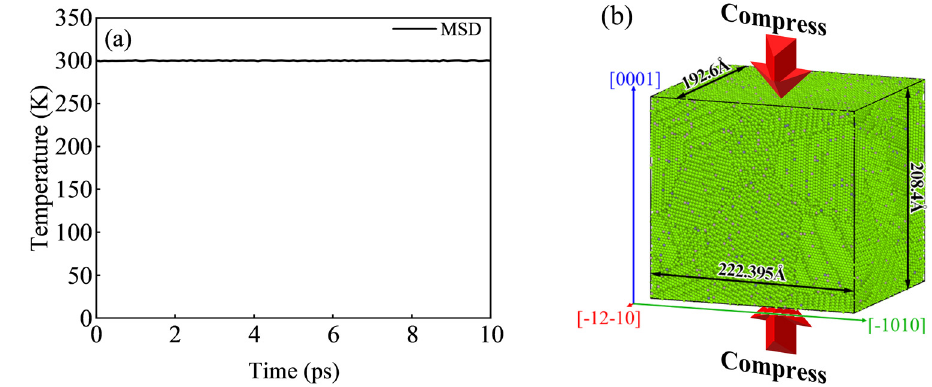
developed by Jang is assigned to the model. X , Y , and Z are all periodic boundary conditions, the time step is 0.001 ps, and the 10 ps is relaxed at 300 K. The change of temperature during the relaxation process is shown in Figure 2a. Keeping the size of the Y - axis model unchanged, the model is uniformly compressed 20 ps along the Z - axis ([ 0001 ] direction ) at the strain rate of 0.01 ps − 1 at 300 K, and the PSC simulation is realized. The process diagram is shown in Figure 2b.